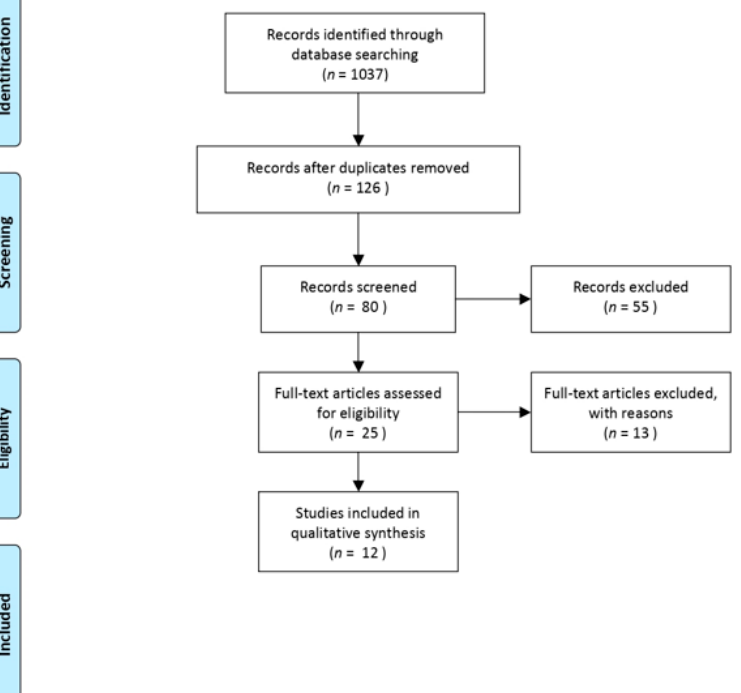
Figure 1. PRISMA flowchart showing the selection process of the papers.